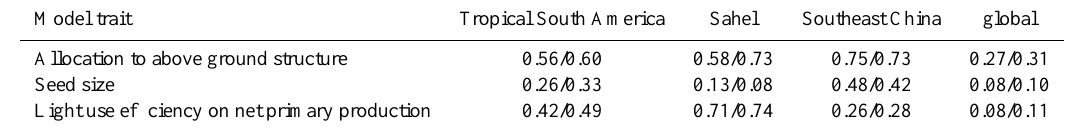
Table 2. Relative importance of the plant functional traits “allocation to above ground structure” (t07), “seed size” (t11), “light use efficiency on net primary production” (t12) for plant functional richness (FR) changes under the B1/A2 scenario. Relative importances are derived from regressing the changes in the plant functional traits to the changes in FR and are expressed as R 2 . Model trait